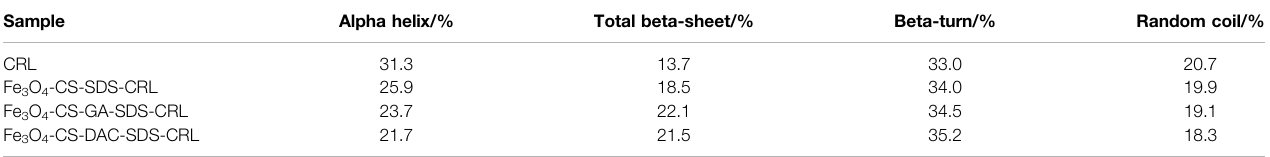
TABLE 3 | Circular dichroism analysis of immobilized CRL.